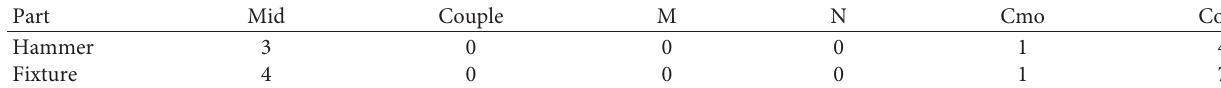
Table 2: FEM model parameters of hammer and